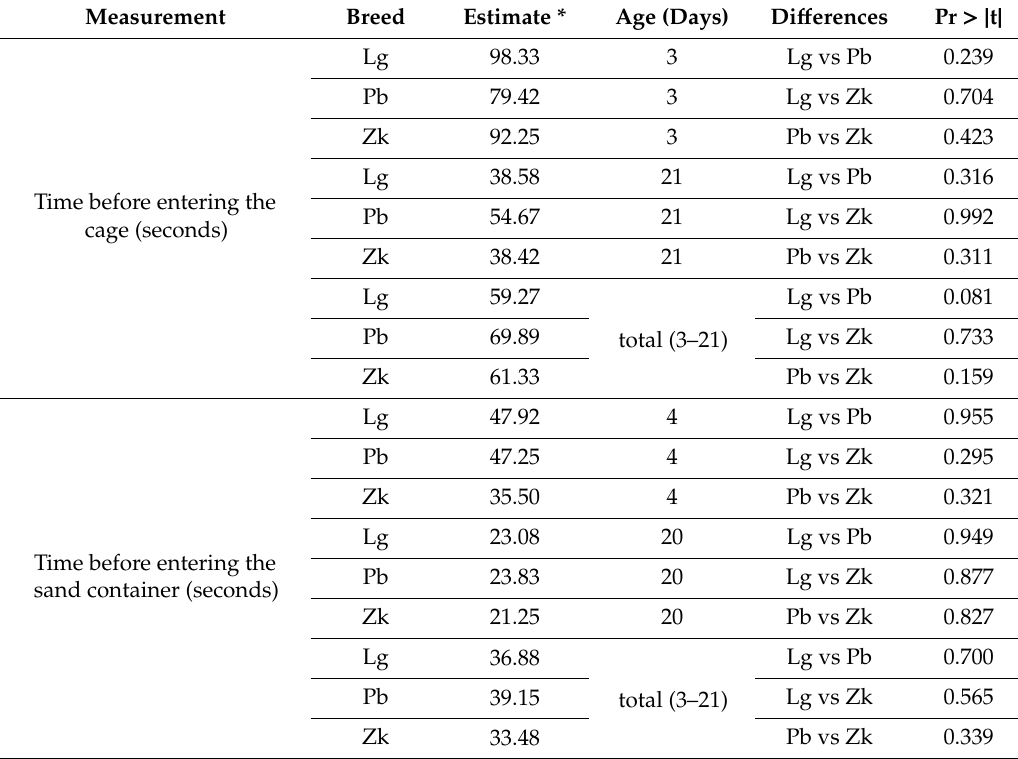
Table 7. Mean time of undertaking activity * and significance of di ff erences between the means in relation to the breed and age of